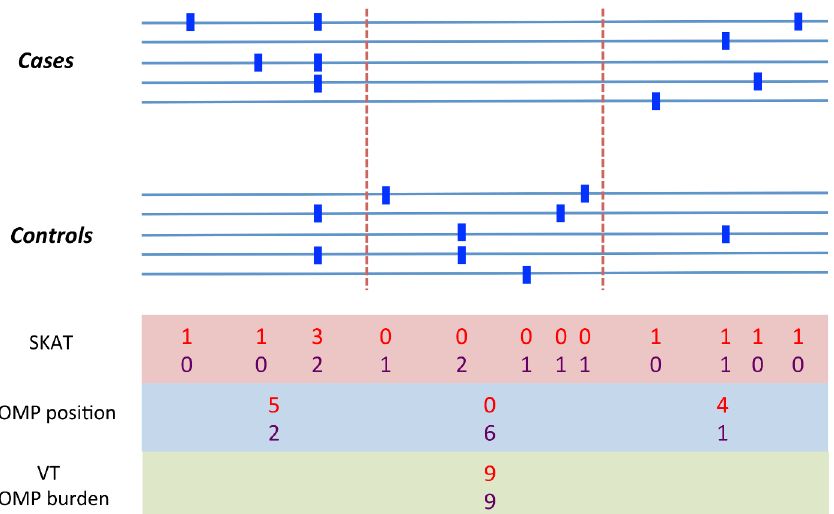
Figure 6. Example variation pattern in which position distribution outperforms burden tests. A toy example of a genomic region containing variants (blue squares) in cases and controls. We assume that the region is important for phenotype. Variant counts in cases (red). Variant counts in controls (purple). Cases and controls each have a total of 9 variants in this region, so Burden statistics ( e.g. , VT or BOMP burden) will not be able to detect that the region is important for phenotype. BOMP’s position distribution statistic collapses variants into short, localized windows (red dashed lines) and detects that the number of variants seen in cases and controls is different within the windows. We note that a method that does not collapse variants, such as SKAT, does not have much power to detect the difference between cases and controls, because at each position the number of variants in cases and controls is similar.